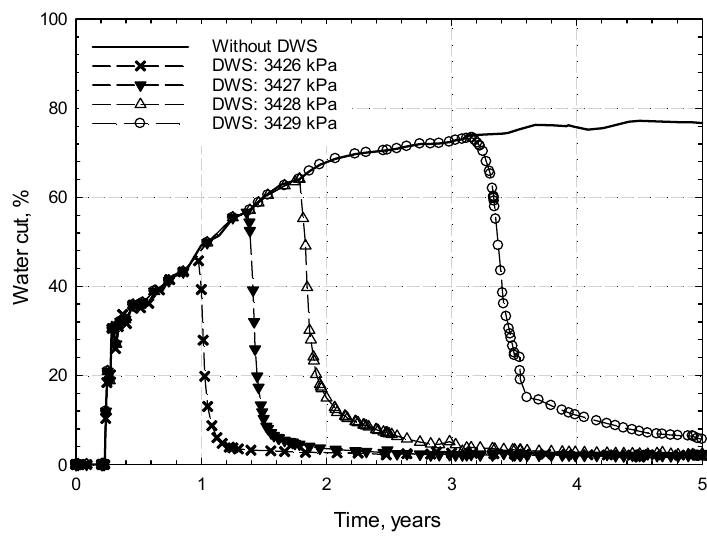
Figure 15. Water cut for the cases with DWS under different pressure constraints in the DWS.